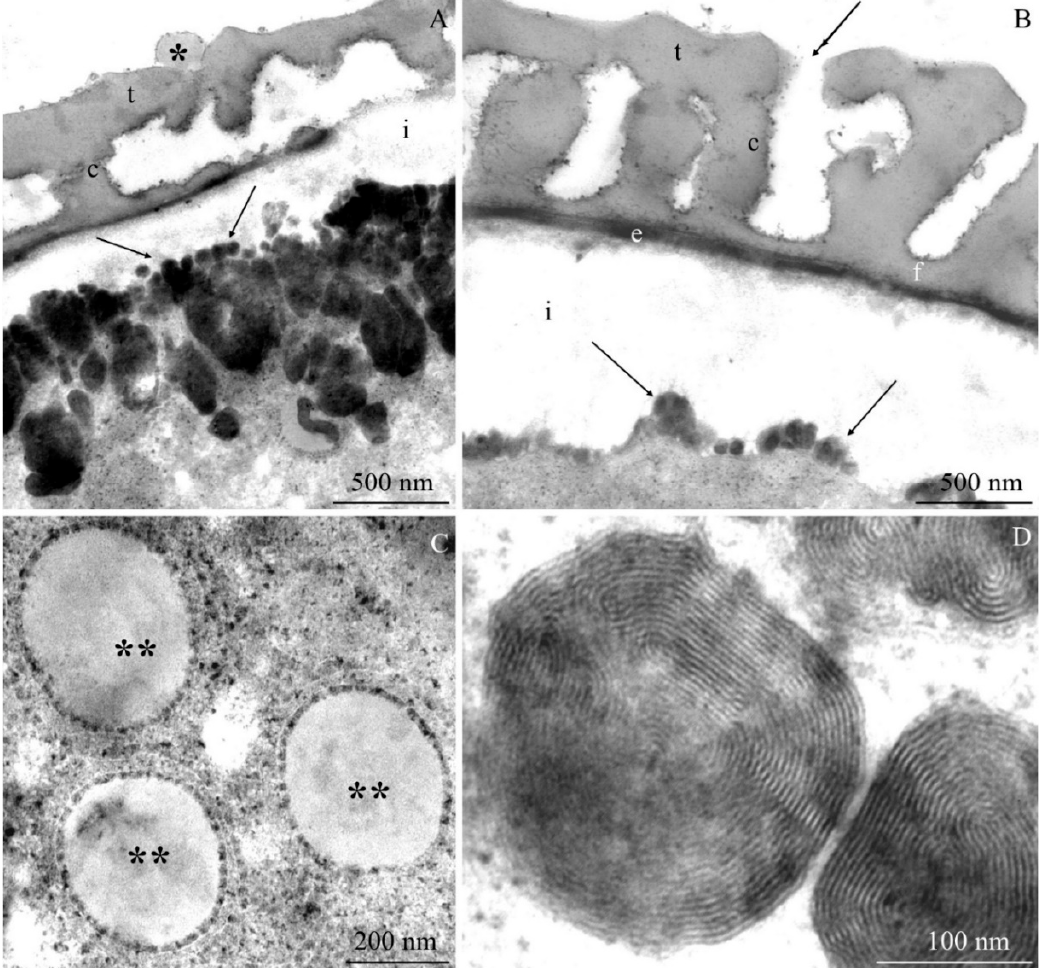
Figure 12. A – D . Fragments of pollen grains in R. idaeus ‘Polka’: ( A , B )—tectum (t), pollenkitt (asteriks) (phot. A), columellae (c), foot layer (f), endoexine (e), electron-dense structures (arrow) near the intine (i); ( C )—electron-dense protoplast, plastoglobules (two asterisks); ( D )—electron-dense structures with a regular concentric arrangement. A – D - TEM.